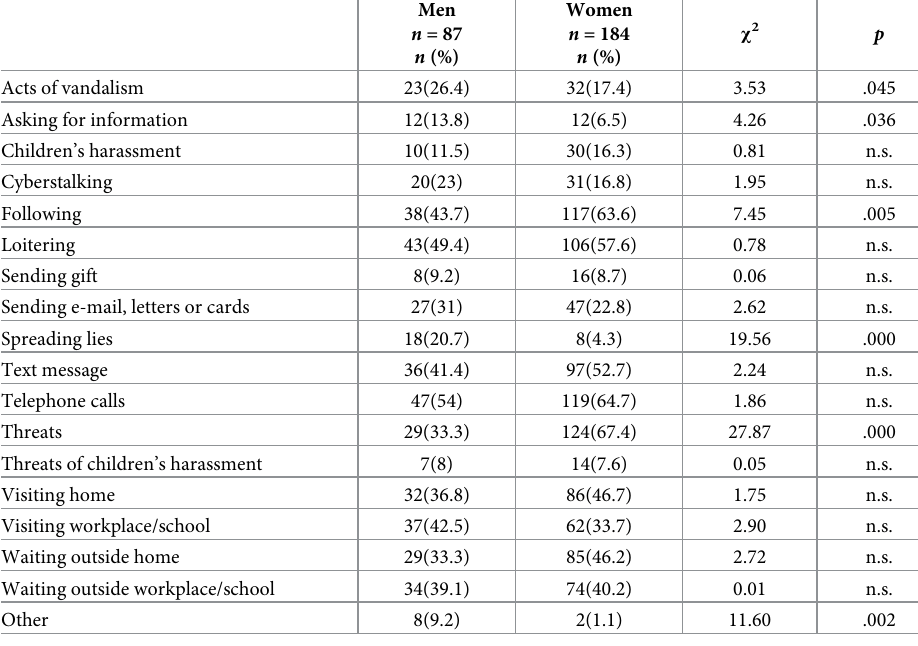
Table 2. Behavior characterizing the stalking campaign in men and women that report to police (N =